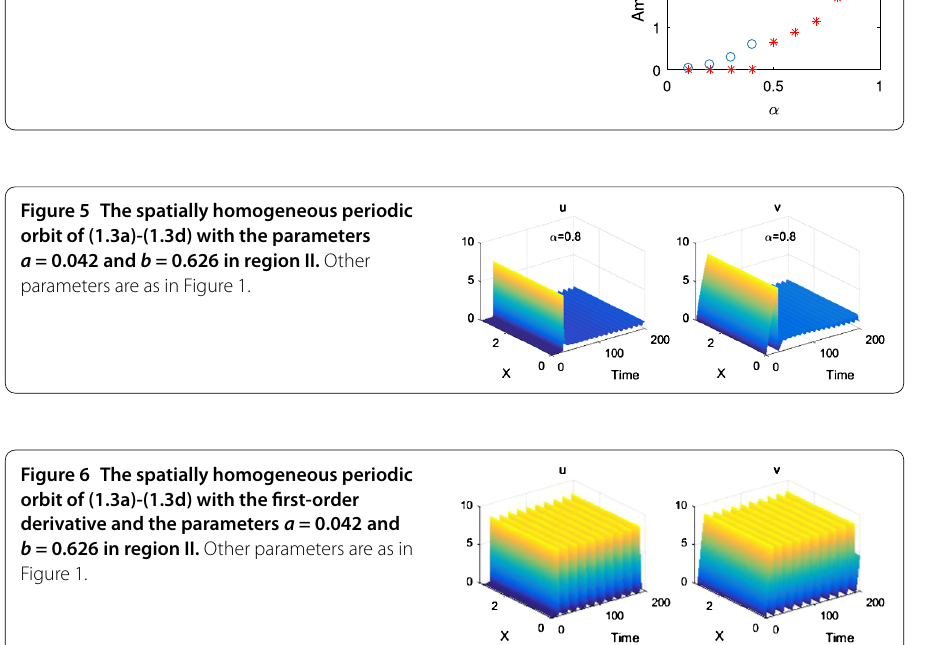
Figure 6 The spatially homogeneous periodic orbit of (1.3a)-(1.3d) with the first-order derivative and the parameters a = 0.042 and b = 0.626 in region II. Other parameters are as in Figure 1.